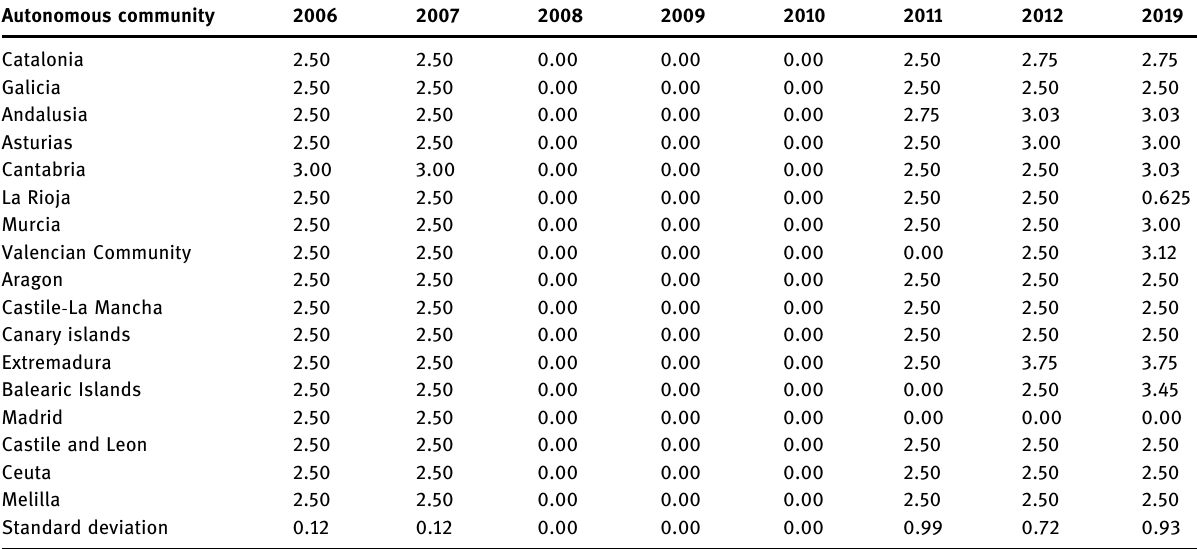
Table 1: Maximum tax rate ( % ) in Wealth Tax by autonomous community, 2006 – 2012 and 2019 Autonomous